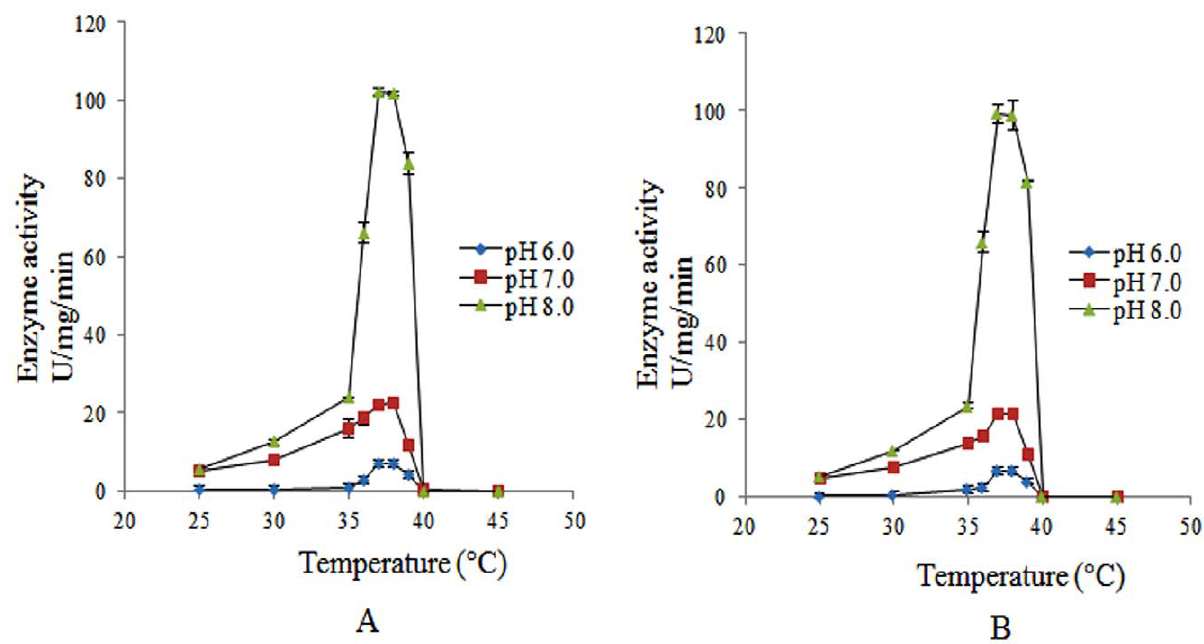
Figure 5. The effect of pH as a function of temperature on the enzyme activity (A) PE-PPE domain. (B) Rv1430 full-length.